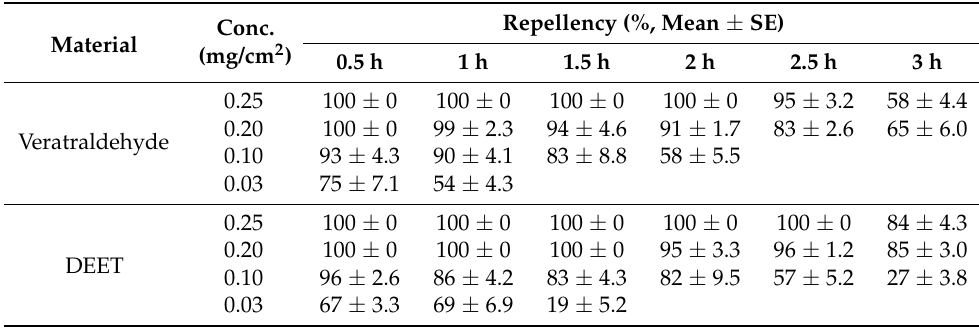
Table 1. The repellent activity of veratraldehyde against Aedes albopictus females using the arm-in- cage